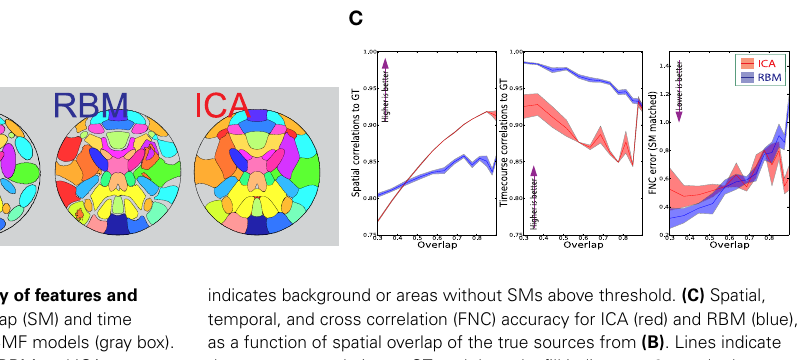
indicates background or areas without SMs above threshold. (C) Spatial, temporal, and cross correlation (FNC) accuracy for ICA (red) and RBM (blue), as a function of spatial overlap of the true sources from (B) . Lines indicate the average correlation to GT, and the color-fill indicates ± 2 standard errors around the